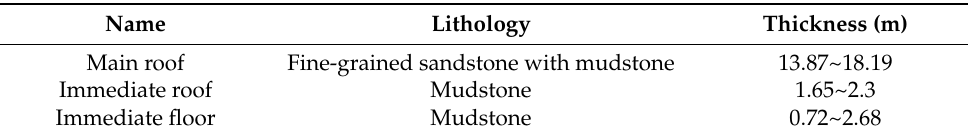
Table 2. Design parameters for the dense pressure-released holes. Spacing of Holes/mm